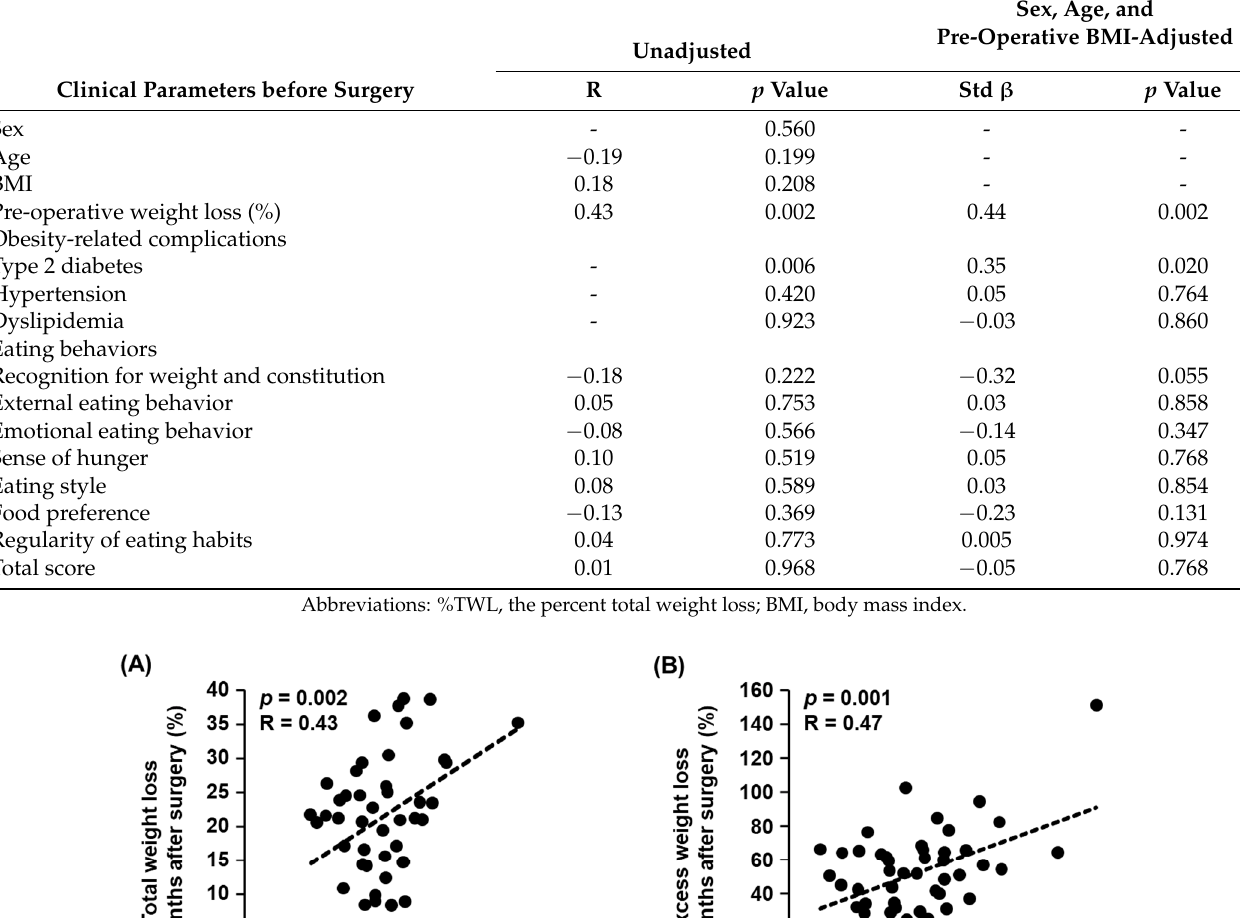
Table 2. Correlations between clinical parameters before surgery and %TWL at 12 months after surgery.